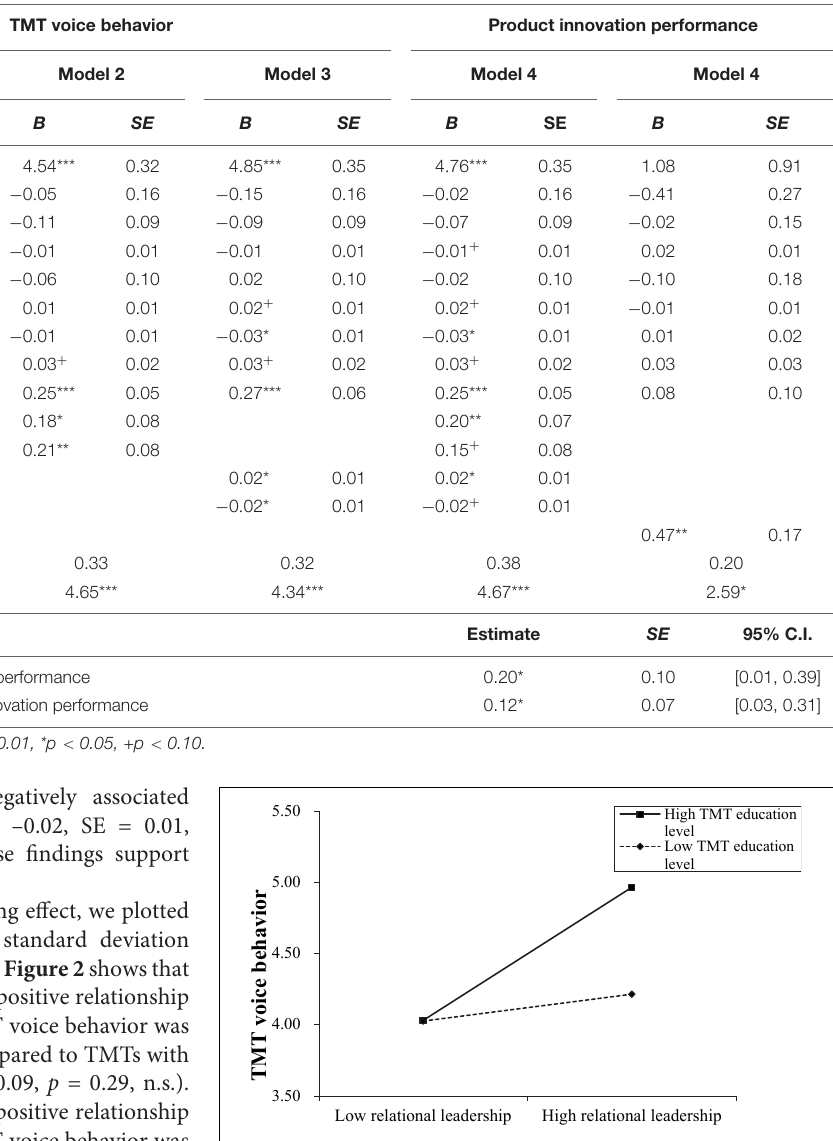
TABLE 2 | Results of hypothesis tests.